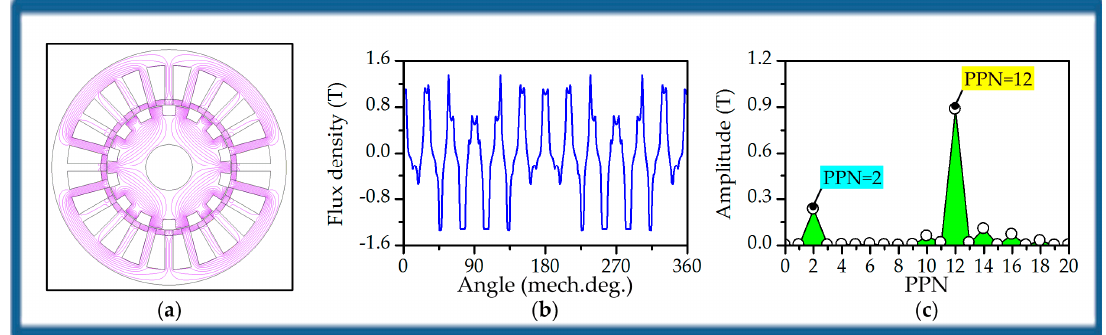
Figure 7. Analysis of magnetic field excited only by rotor PMs: ( a ) Flux lines distribution; ( b ) Flux density in the air-gap; and, ( c ) Harmonic spectrum.